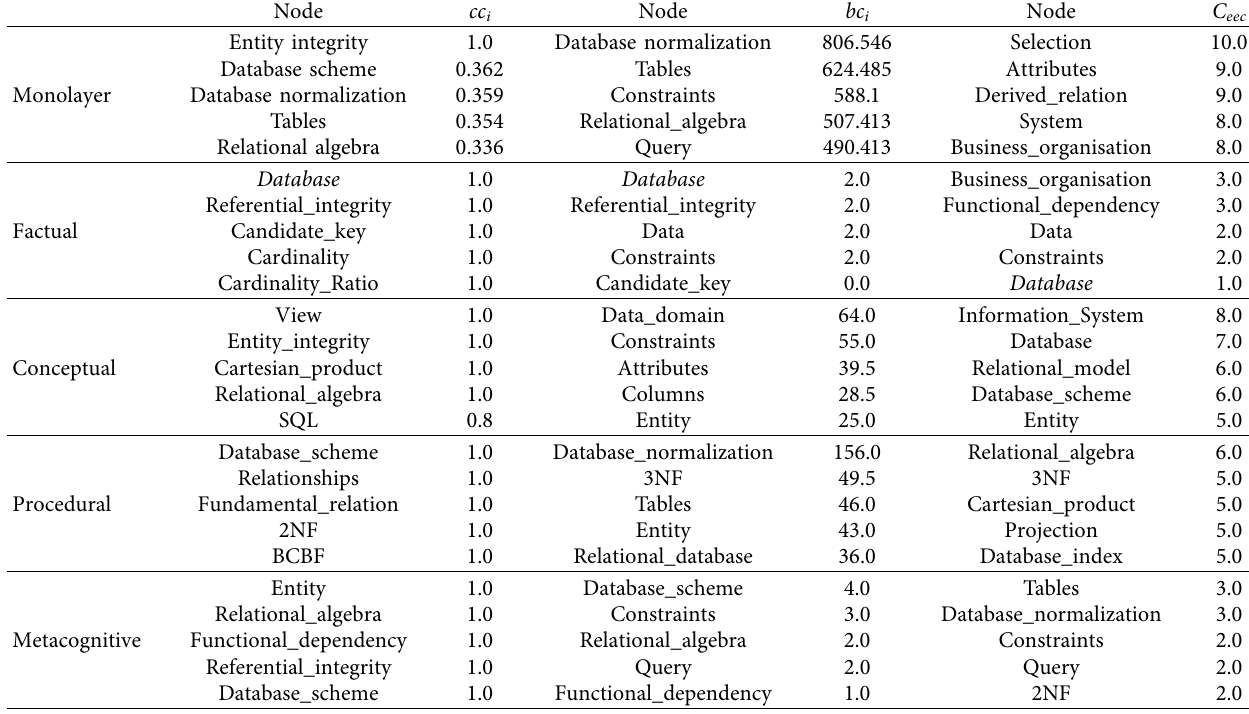
Table 4: Top five highly ranked nodes (concepts) according to the closeness centrality ( cc ( C eec ) in a monolayer